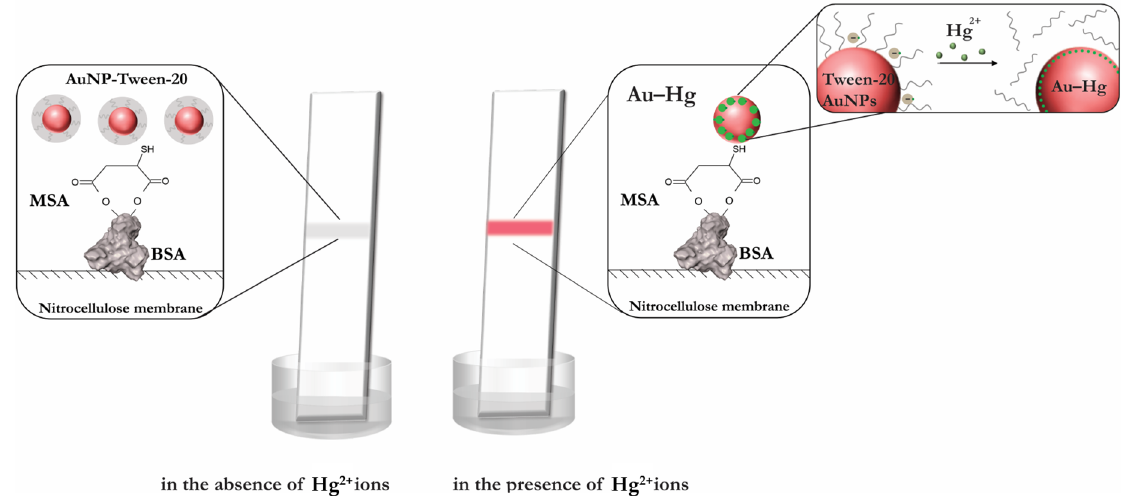
Figure 1. The working principle of the lateral flow test for Hg 2+